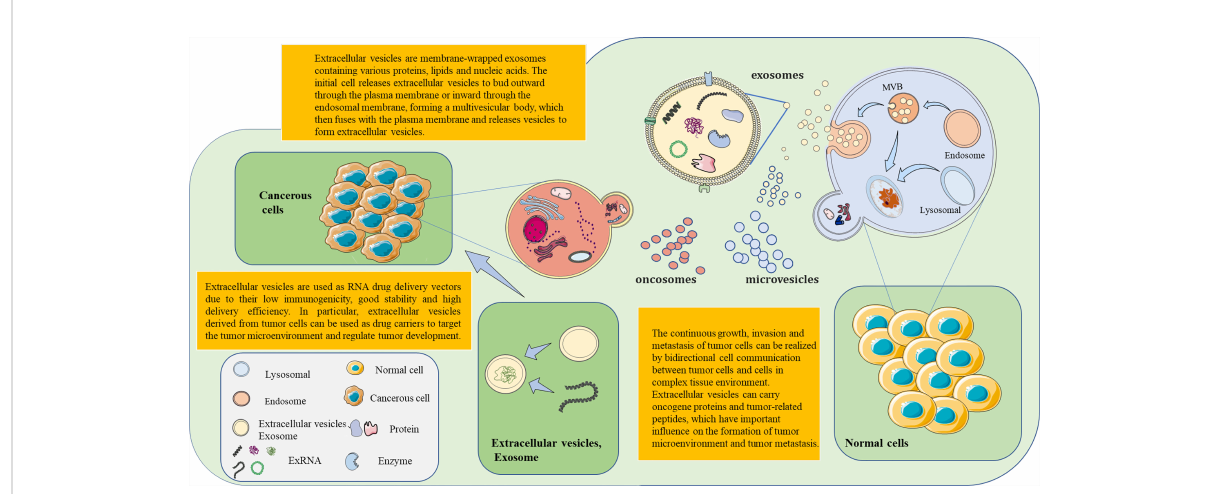
FIGURE 1 The formation of extracellular vesicles (EVs) and exosomes is based on continuous cell membrane renewal. EVs have three forms: microvesicles, exosomes, and tumor bodies. Microvesicles arise from the inward budding of the membrane. Exosomes are produced by the outward budding of the membrane. Tumor bodies are produced by tumor cells. The invagination of the cell membrane forms the endosome, which then assembles the components within the cell. This results in the formation of multivesicular bodies (MVBs). MVBs then fuse with the cell membrane. EVs within MVBs are released from the cell. EVs (exosomes) contain nucleic acids, lipids, and proteins from the source cell. These EVs, which carry information molecules, play an important role in the communication of information between cells. Based on the performance of exosomes as molecular carriers, therapeutic drugs (e.g., small interfering RNAs) are encapsulated in exosomes in vitro for targeted delivery to related cells. This opens a new horizon for novel precision therapy